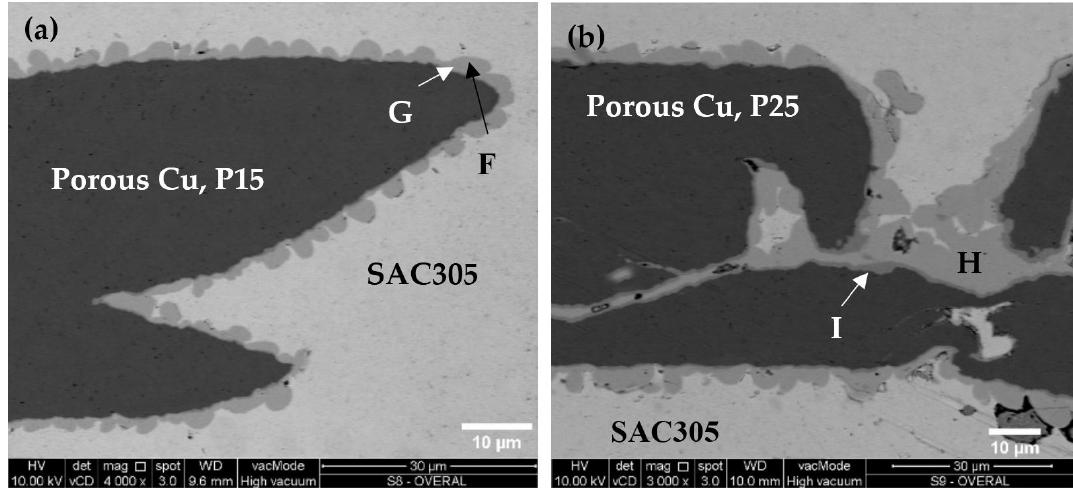
Figure 12. Formation of IMC layer at solder/porous Cu for solder joint soldered with ( a ) P15 and ( b ) P25 at 307 °C with a holding time of 300 s. Table 4. The element atomic percentage by energy dispersive X-ray (EDX) analysis for Figures 11 and 12.